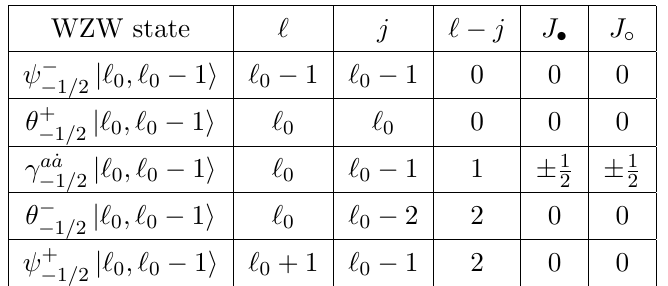
Table 8 . Level N e(cid:11) = 0 states in the NS sector. The (cid:12)rst two states satisfy the BPS condition ‘ = j ; the remaining six states are not